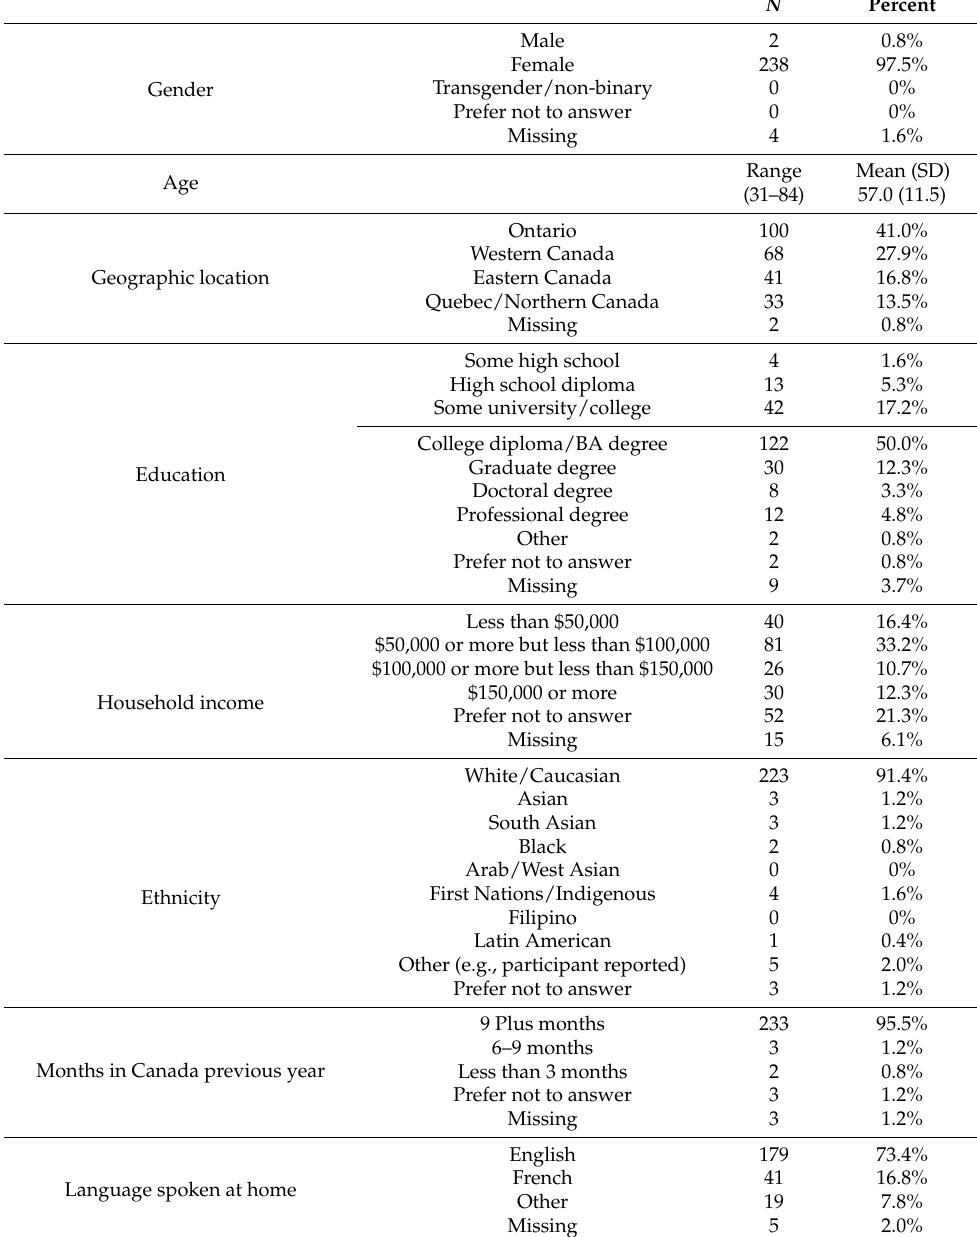
Table 1. Self-reported demographics and breast cancer-specific characteristics ( N =